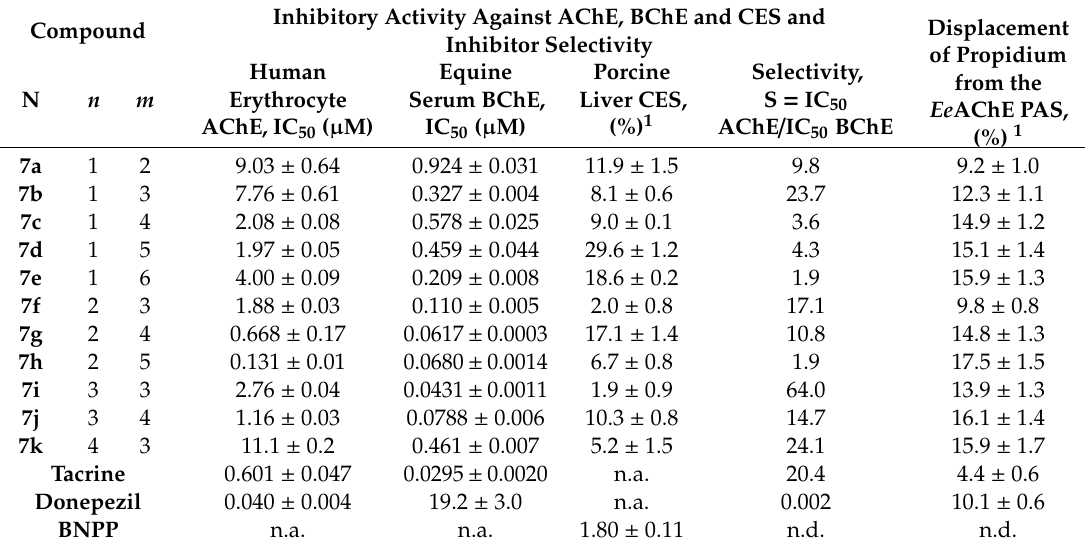
Table 1. Esterase profile of conjugates 7 and their ability to displace propidium.